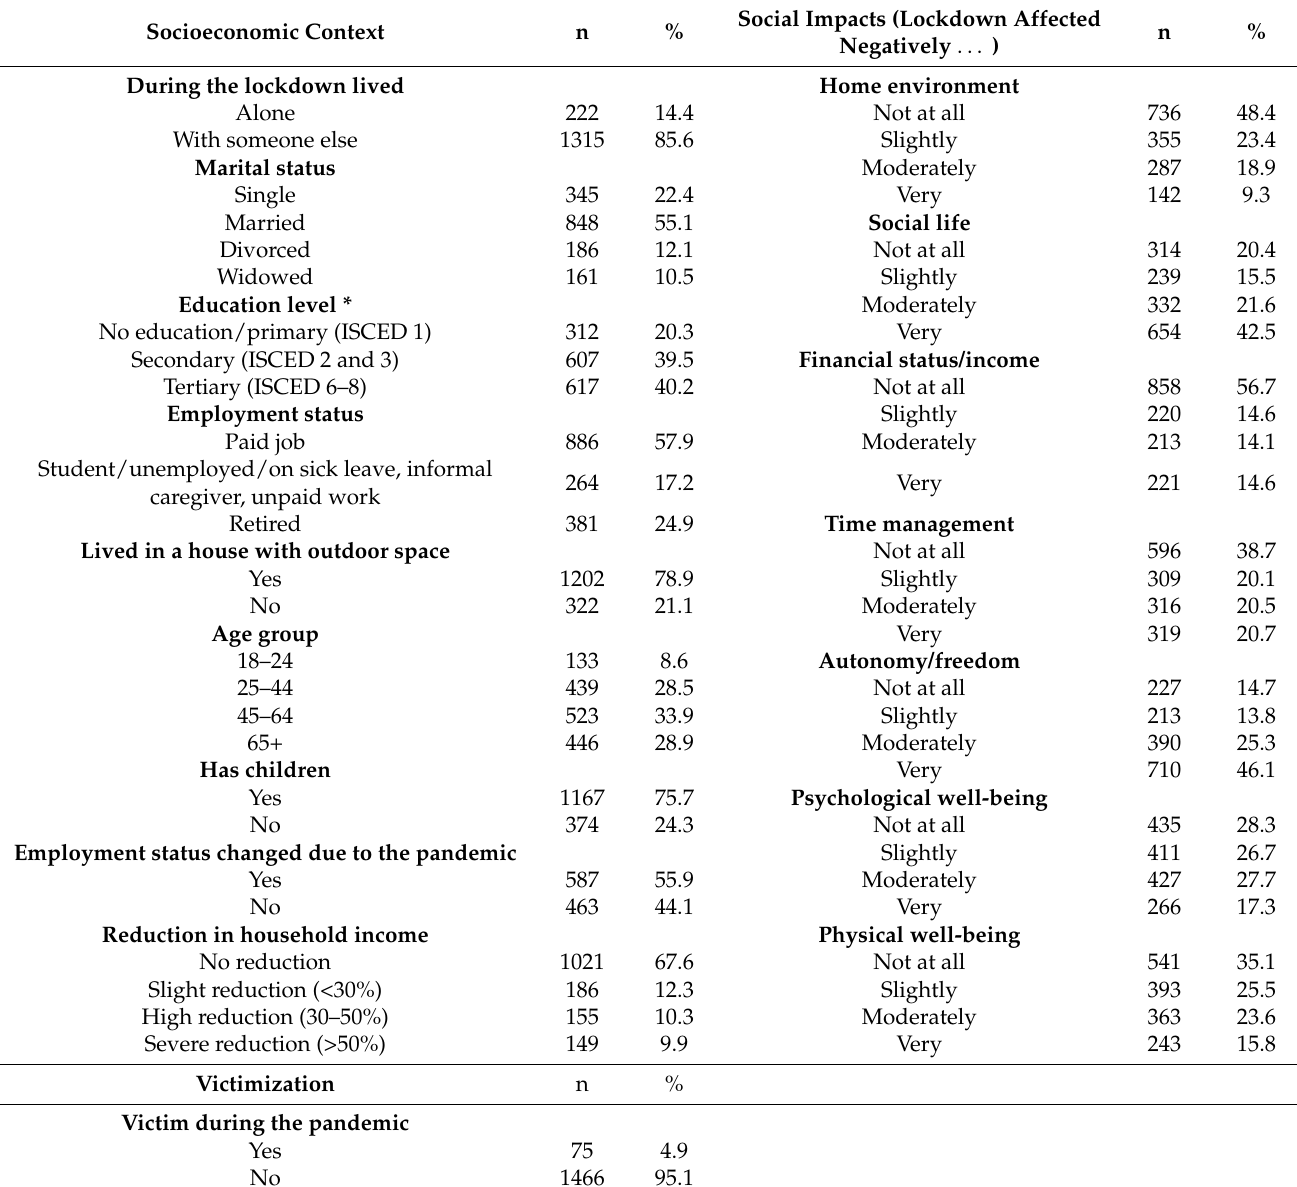
Table 1. Frequency distribution of the selected